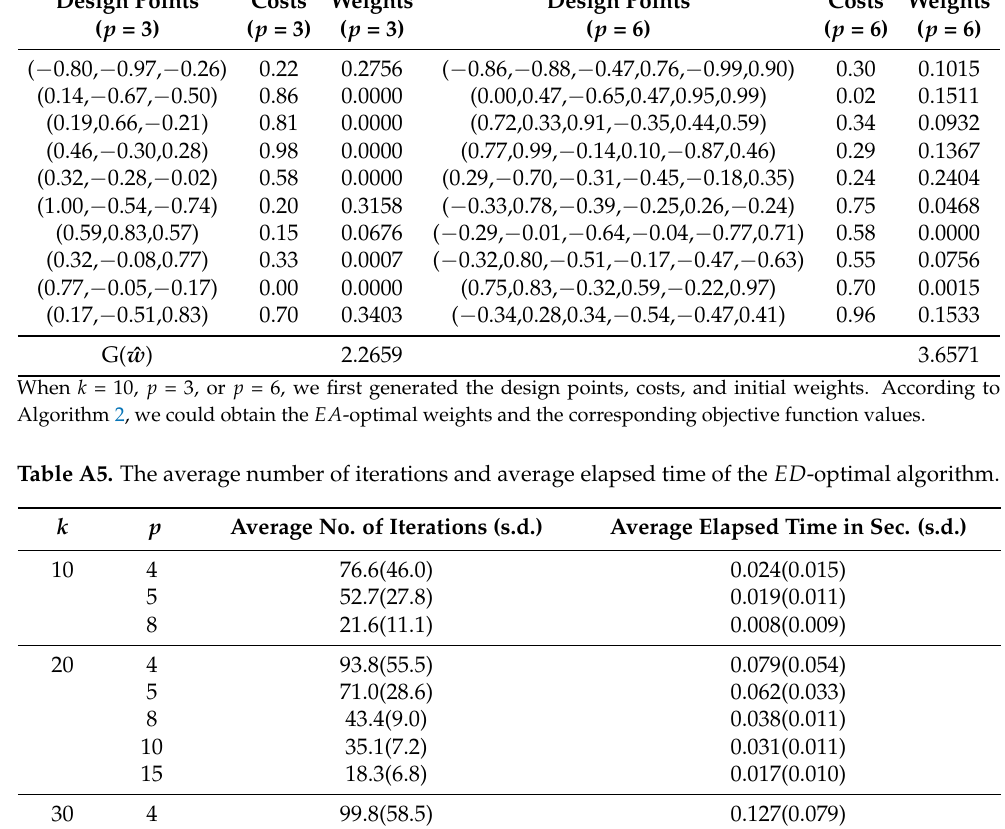
Table A4. Design points, costs, EA -optimal weights, and values of objective function (4) when k = 10. Design Points